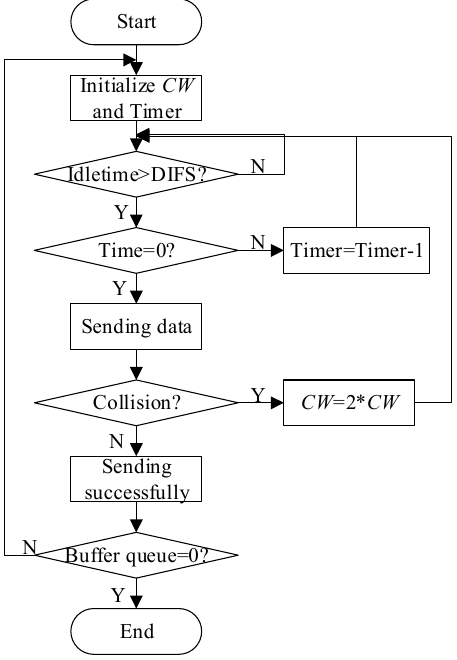
Figure 2. Data transmission chart.